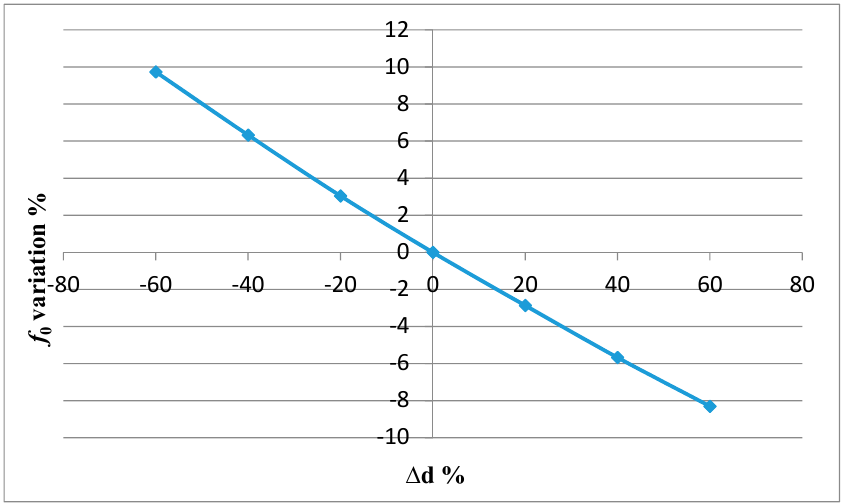
Figure 16. Sensitivity of diameter reduction vs. f 0 .